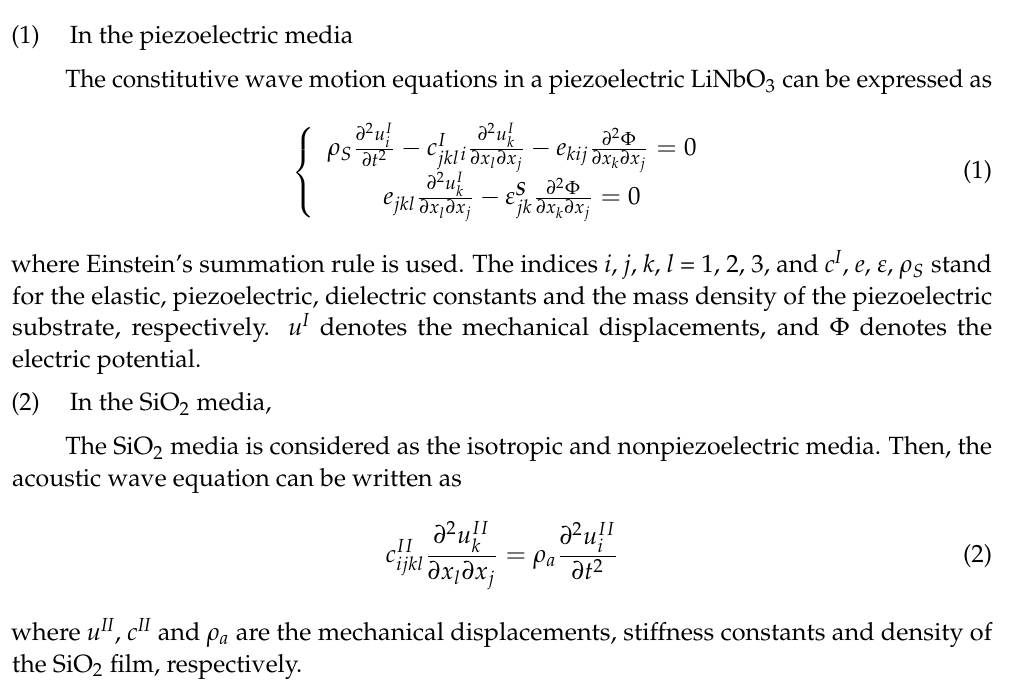
Figure 2. The layered media model (FeGa/SiO 2 /LiNbO 3 ).